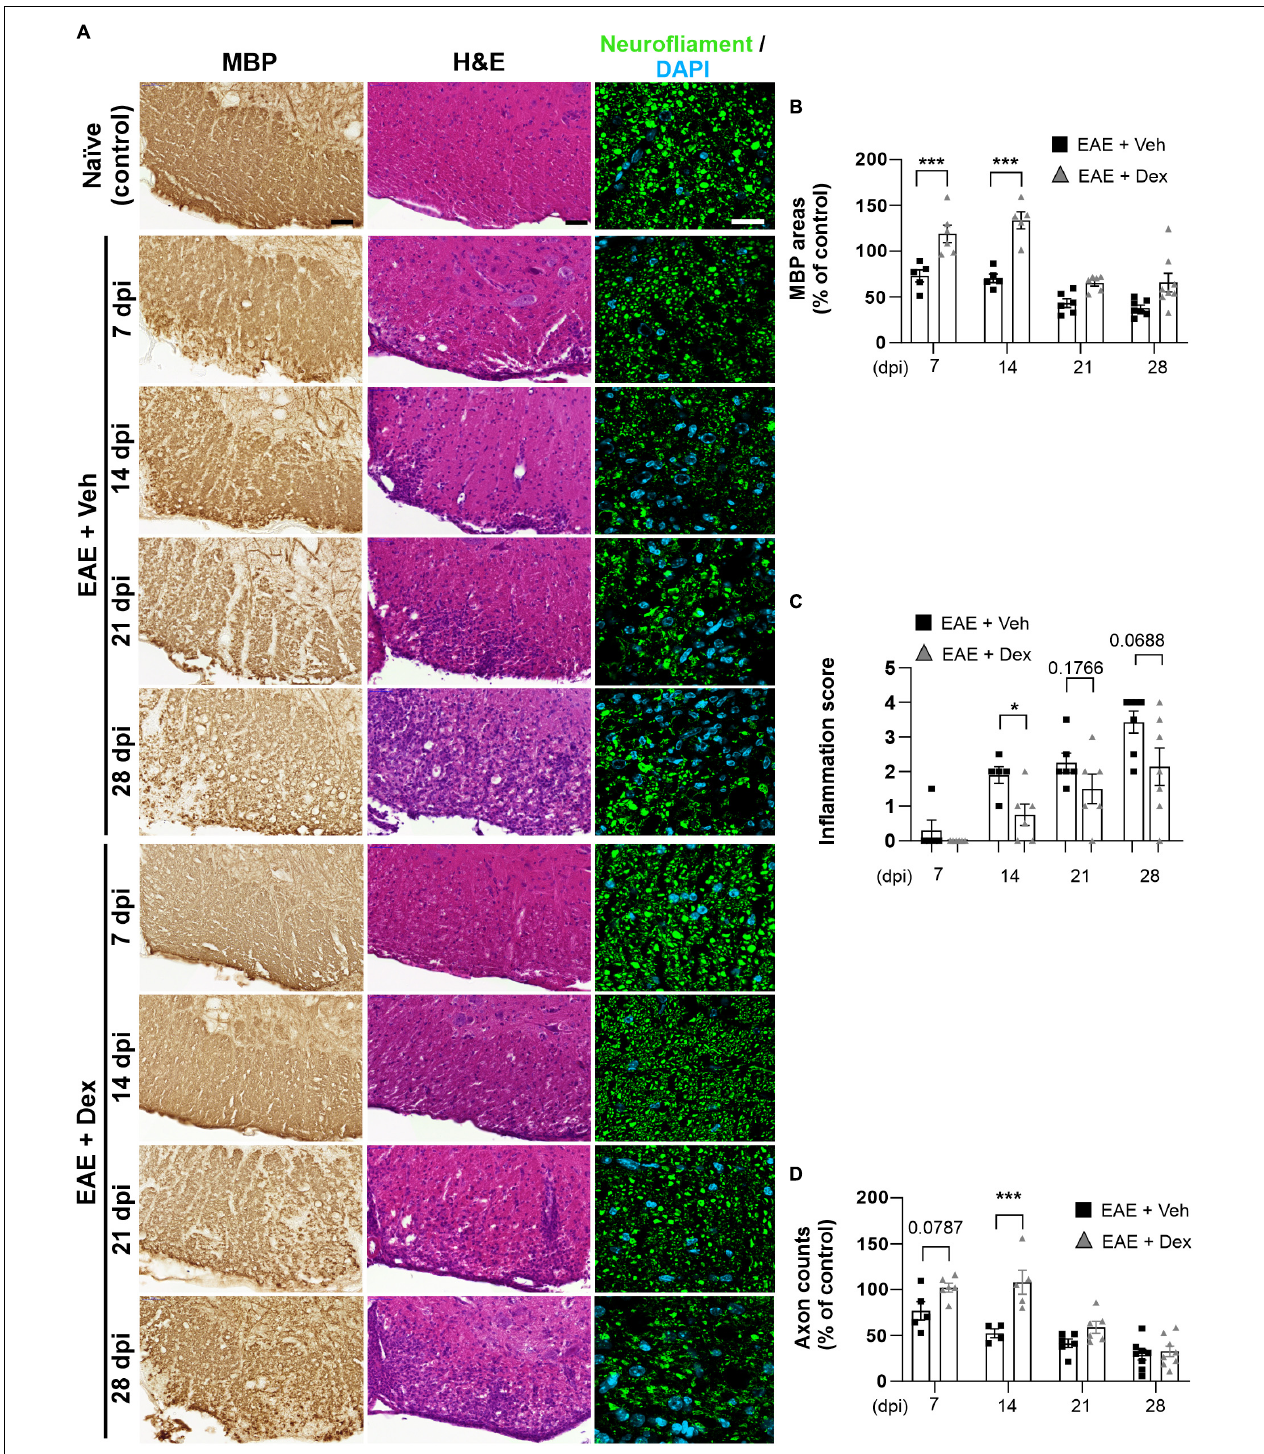
FIGURE 2 | Dexamethasone inhibited myelin and axon loss, as well as immune cell infiltration in the early stage of EAE. (A) Representative images from MBP (Left), Hematoxylin-Eosin (H&E, Center), and neurofilament (Right; Green: Neurofilaments, Cyan: DAPI nuclear stain) immunostained mouse spinal cords at 7, 14, 21, and 28 dpi. (B) Quantification of MBP area at each time point. *** P < 0.001, Mean ± SEM. n = 5–8 per each group. (C) Evaluation of inflammation score from hematoxylin-eosin staining. * P < 0.05, ** P < 0.01, and *** P < 0.001, Mean ± SEM, significance base on unpaired t -test. n = 5–7 per each group. (D) Quantification of the number of neurofilament-positive axons. *** P < 0.001, Mean ± SEM. n = 5–7 per each group. (B,D) 2-way ANOVA followed by Sidak’s post hoc test for multiple comparisons. Scale bar; 50 µ m for MBP, H&E. 20 µ m for neurofilament. Data from 4 repeated experiments.